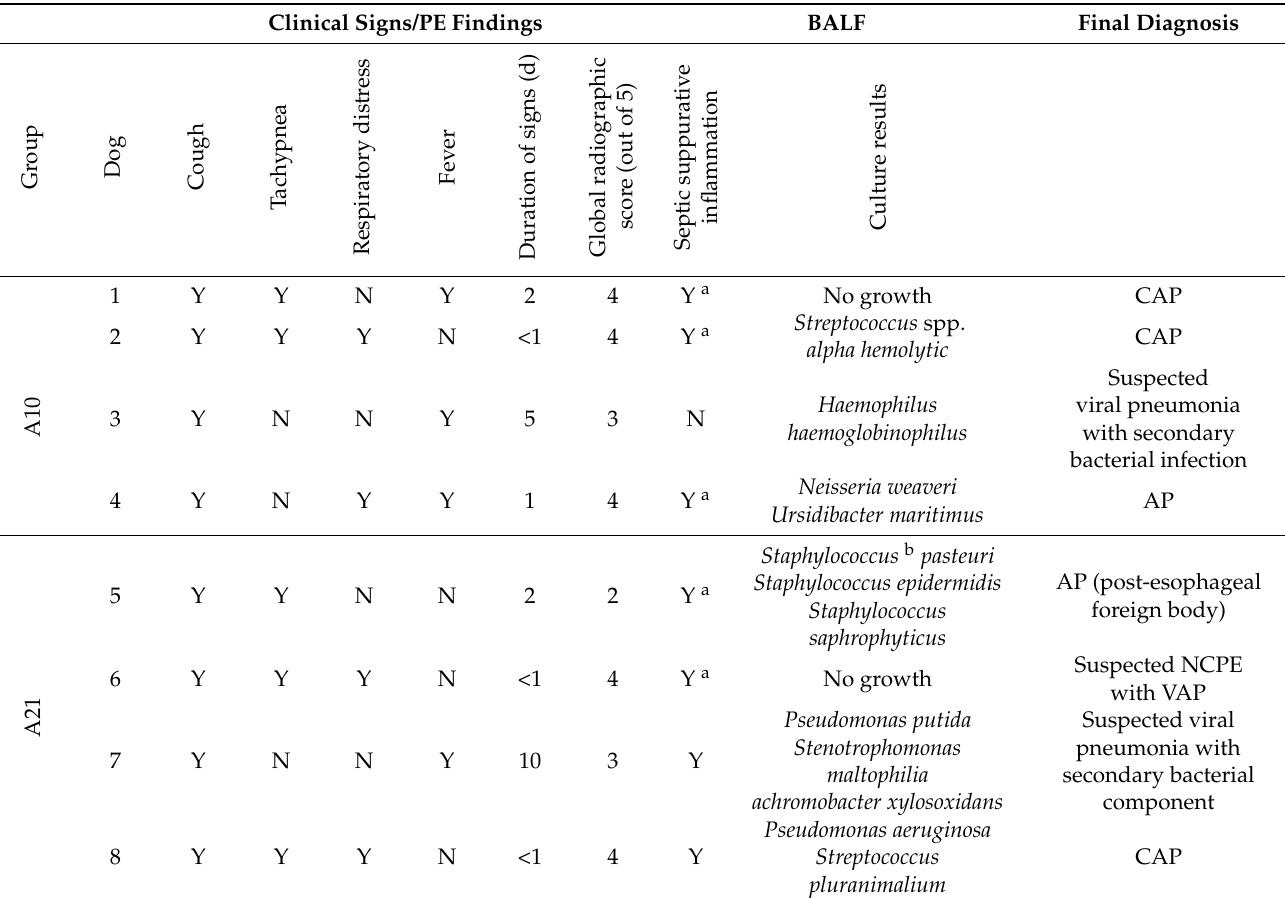
Table 2. Summary of the clinical signs, diagnostic results and final diagnoses for dogs enrolled in each group. Clinical Signs/PE Findings BALF Final